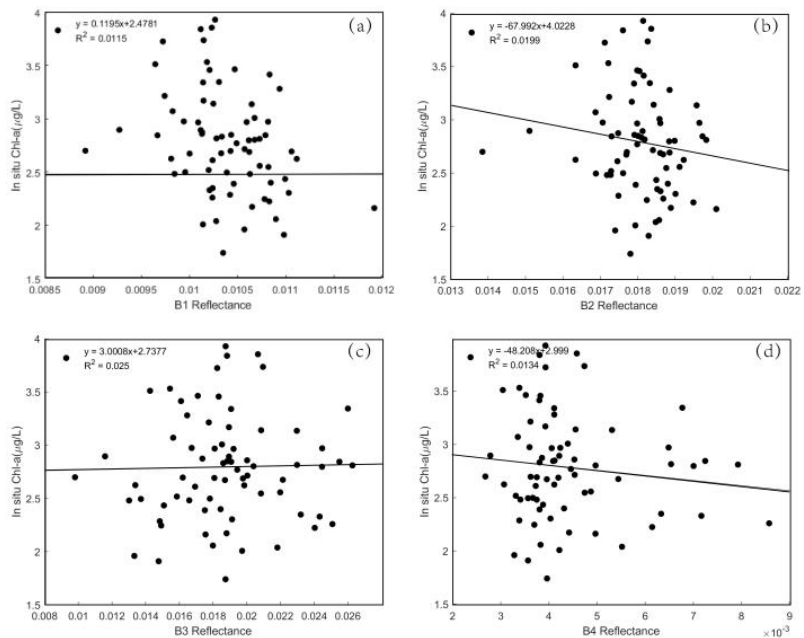
Figure 3. Correlation between band reflectance and natural logarithm of the sampled Chl-a concen- tration. ( a – d ): The linear relationship between the Rrs of band 1, 2, 3, 4 and natural logarithm of the sampled Chl-a concentration. The abscissa is the value obtained after atmospheric correction, and the ordinate is the value of in situ Chl-a concentration.